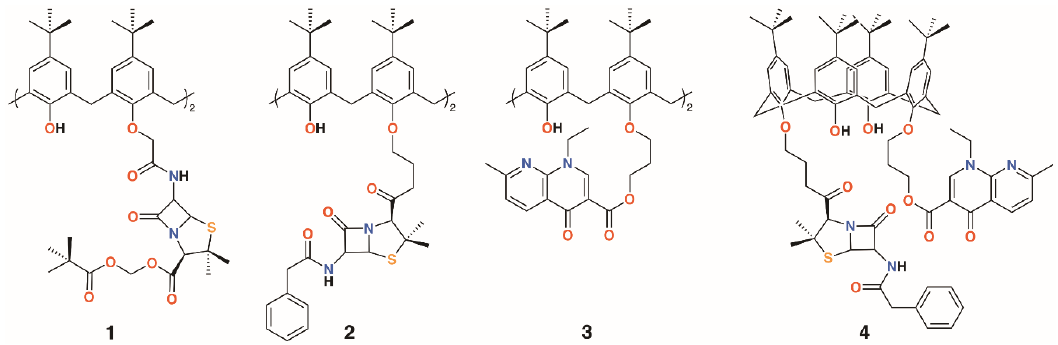
Figure 3. Regnouf-de-Vains’ calixarene prodrugs.